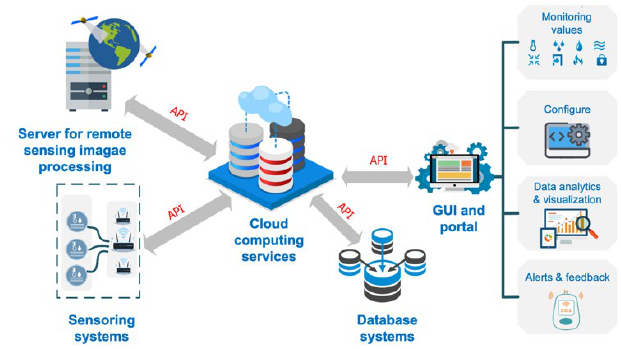
Figure 1. The overview of the proposed